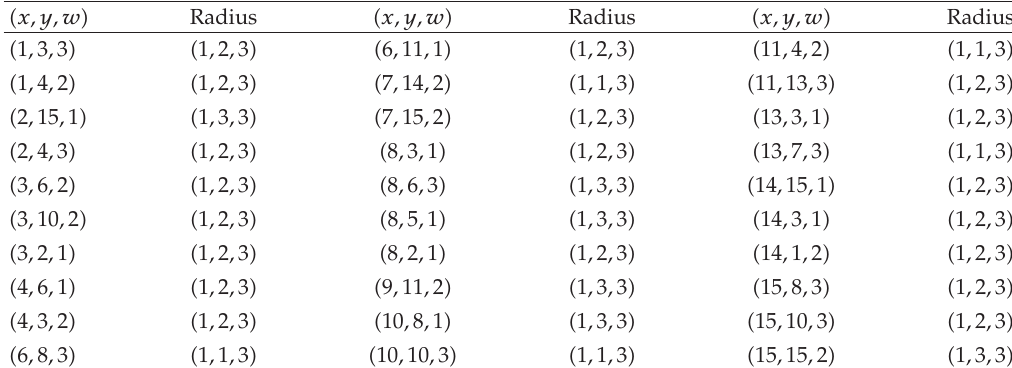
Table 7: Data for 30-point